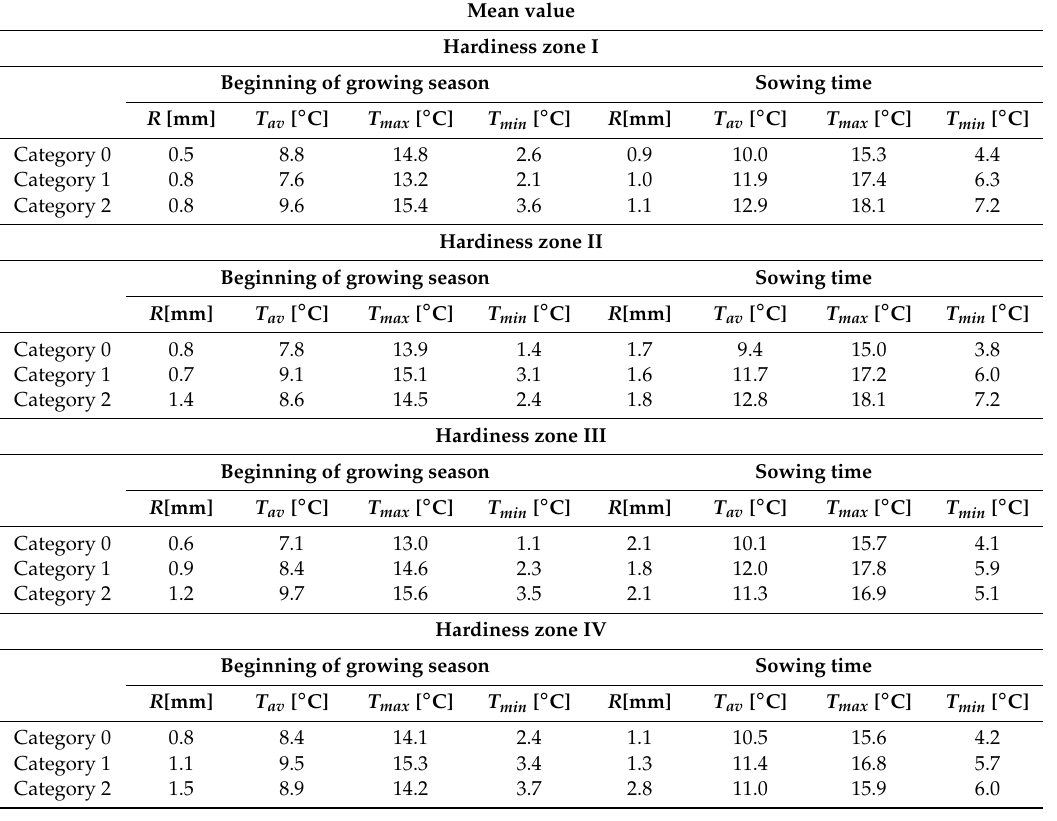
Figure 3. Data analysis procedure. Table 2. Statistical values of the weather data variables at the starting point of the